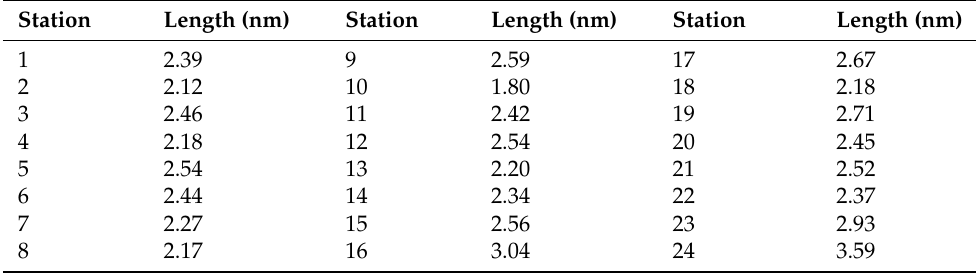
Table 1. The length of each station (nautical mile(nm)).